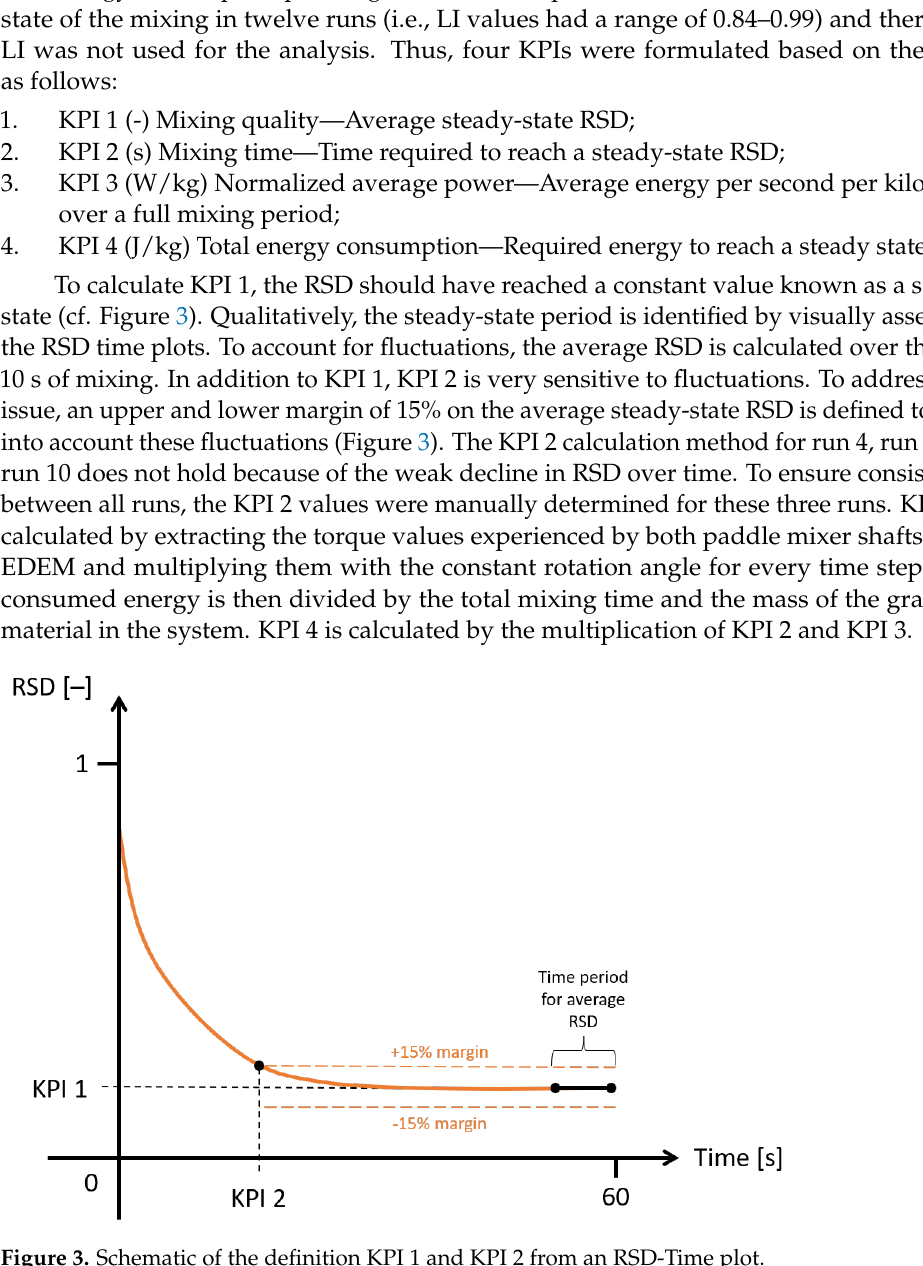
Figure 3. Schematic of the definition KPI 1 and KPI 2 from an RSD-Time plot.